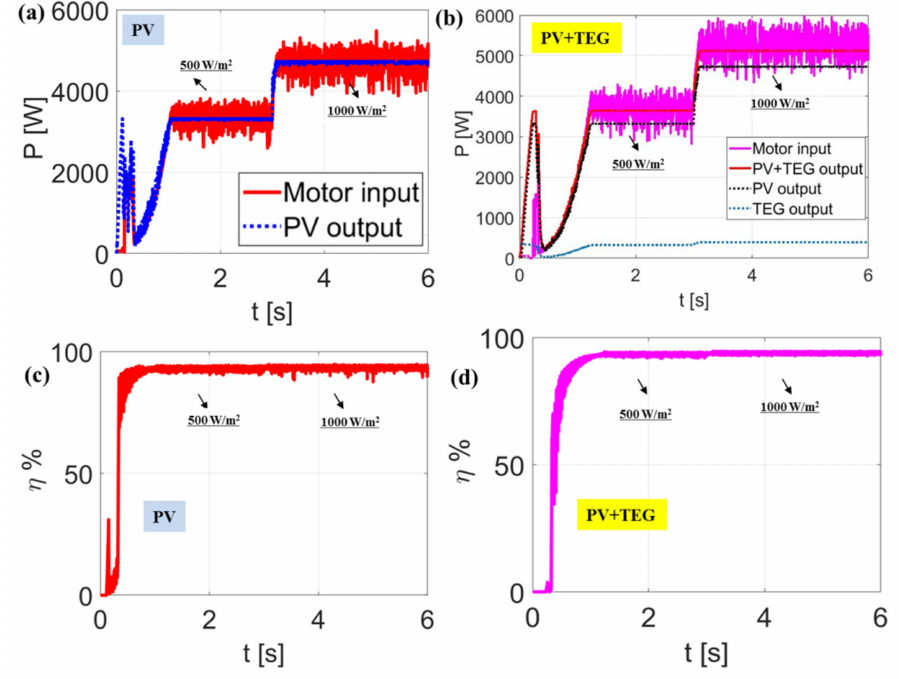
Figure 10. The power as a function of time at two irradiation levels ( a , b ). The motor efficiency versus time ( c , d